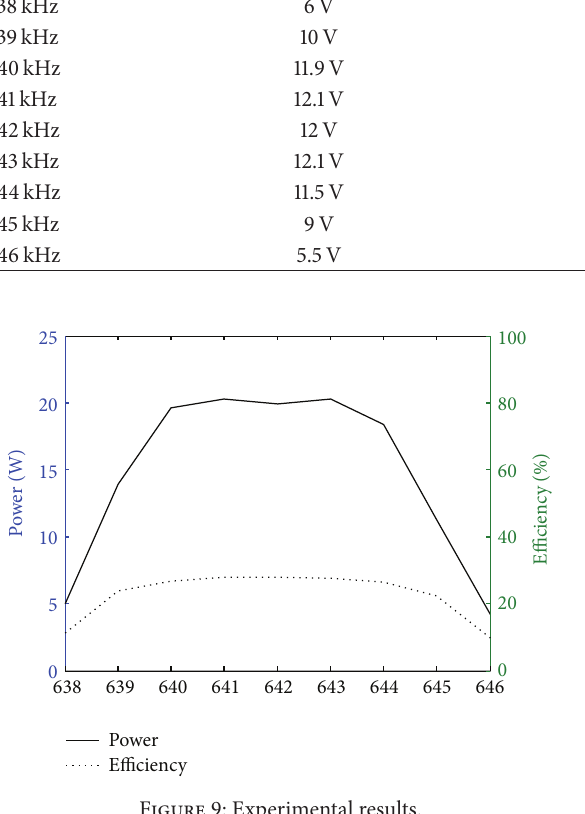
Figure 9: Experimental